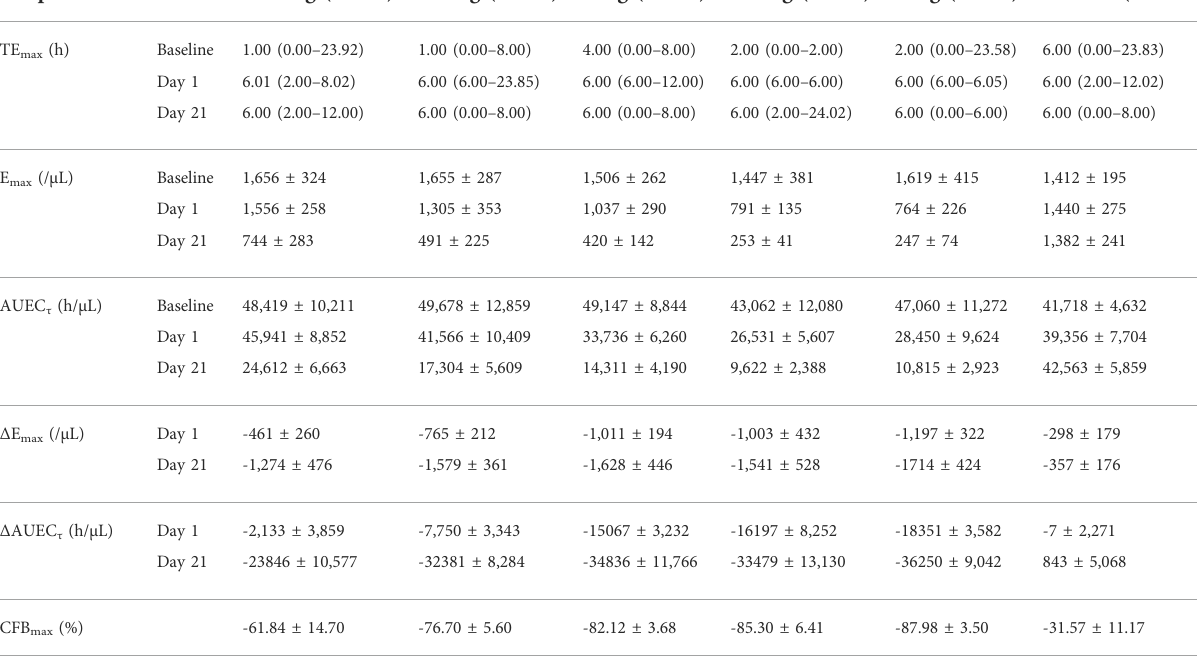
TABLE 2 Pharmacodynamic parameters of LC51-0255 after daily oral administration of 0.25, 0.5, 1, 1.5, 2 mg of LC51-0255 or placebo for 21